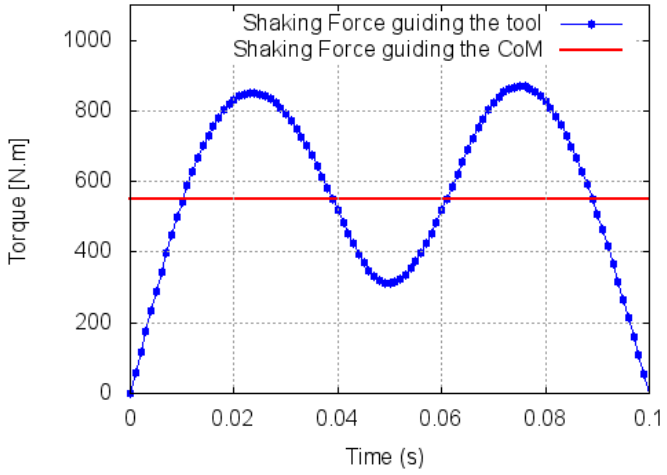
Figure 7. Comparison of the shaking force: The blue curve is the magnitude of the shaking force when the tool is guided with a cycloidal profile. The red line is the magnitude of the shaking force when the global CoM of the manipulator is guided with a “bang-bang”